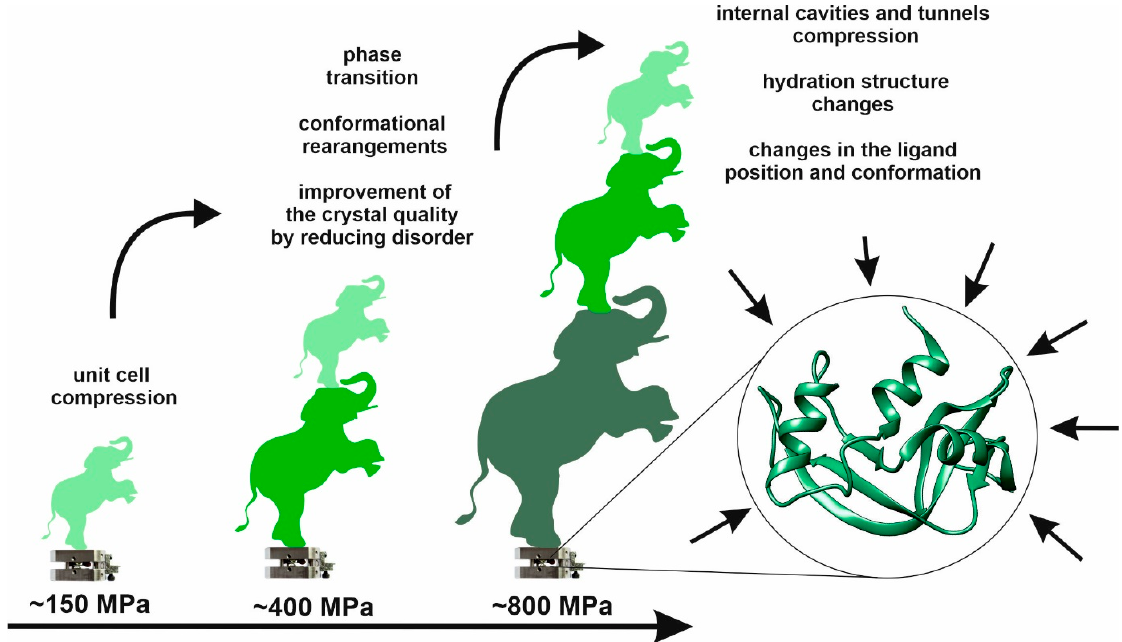
Figure 2. Features that can change upon pressurization of the macromolecular crystal.